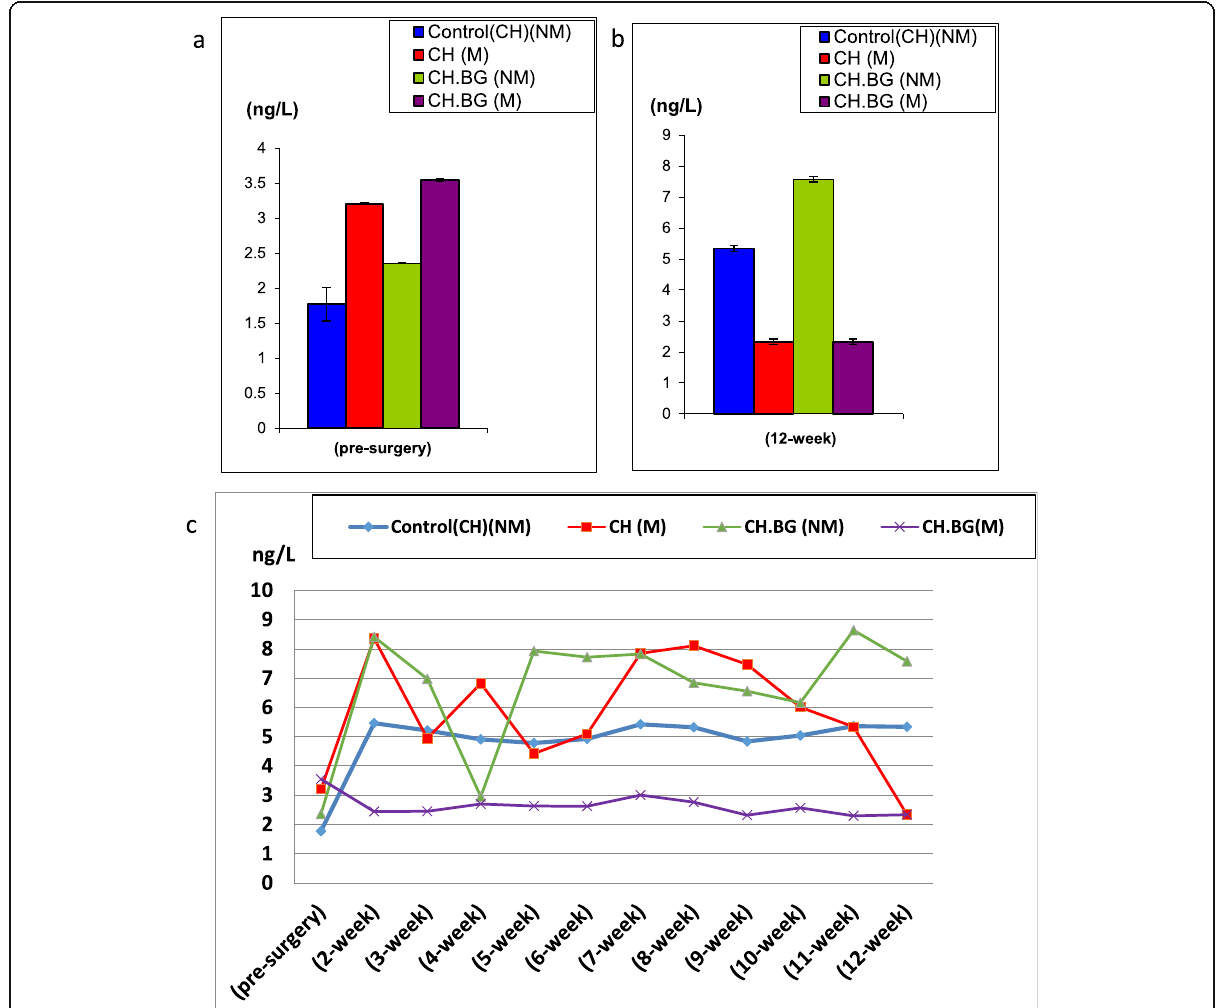
Fig. 3 Mean ± SD of dog serum BMP-2 level in the different groups. a Pre-surgery. b 12 weeks. c During